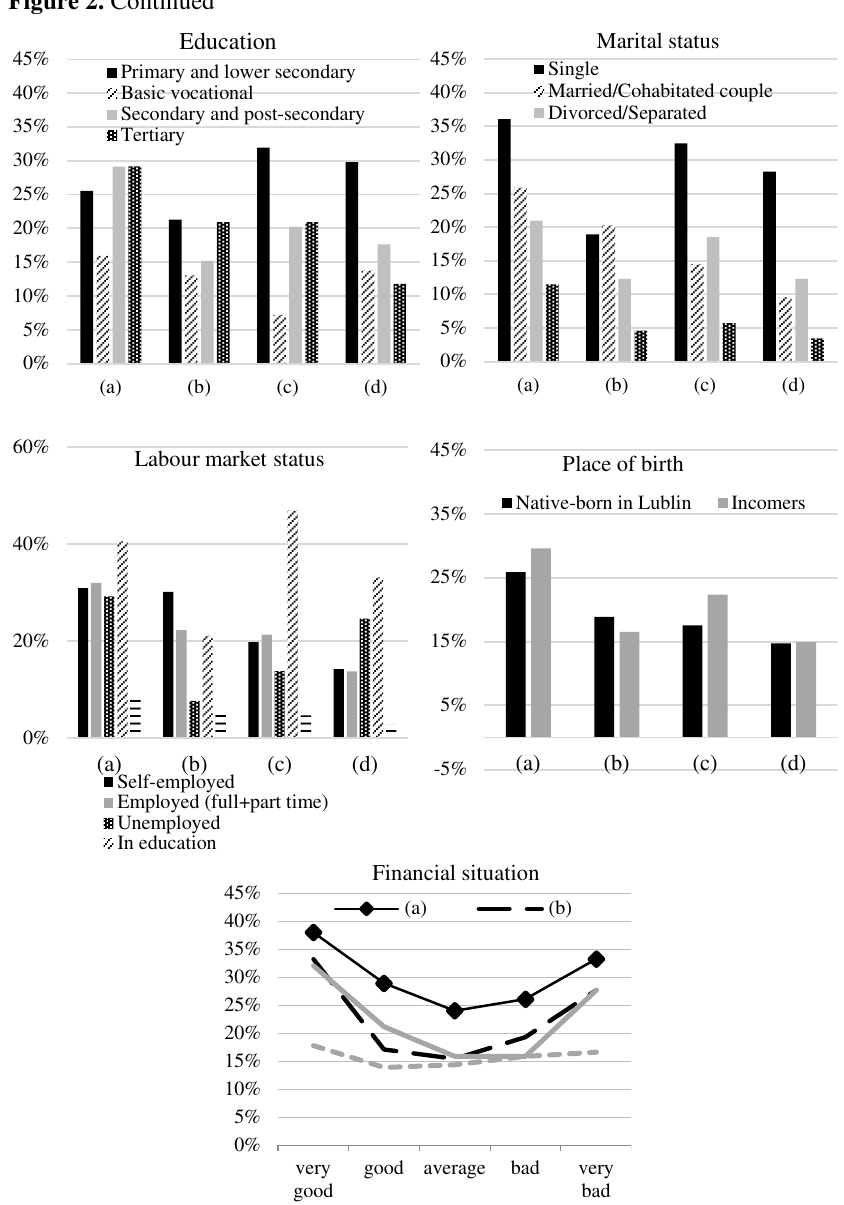
close to Lublin, (c) – a city outside the voivodship, (d) – another